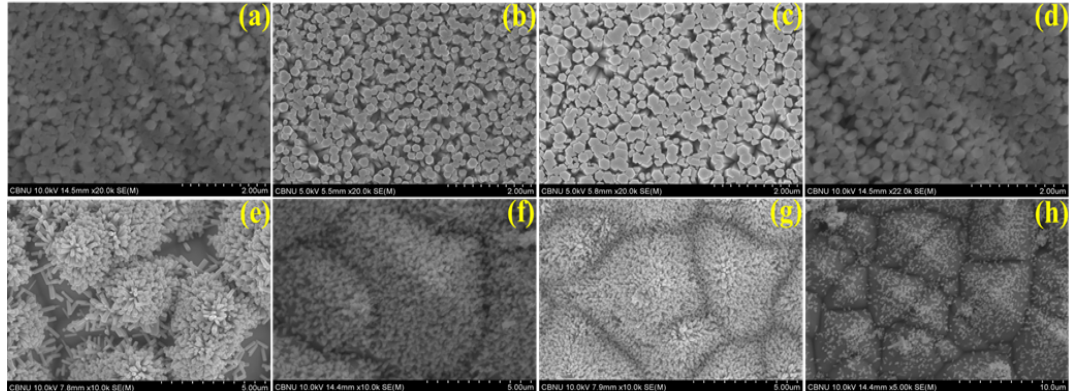
Figure 2. Field emission scanning electron microscopy (FESEM) image of the top view of ZnO NRs of treatment times ( a ) 3 h, ( b ) 4 h, ( c ) 5 h, and ( d ) 6 h on bare Si substrate and ( e ) 3 h, ( f ) 4 h, ( g ) 5 h, and ( h ) 6 h on textured Si substrate.